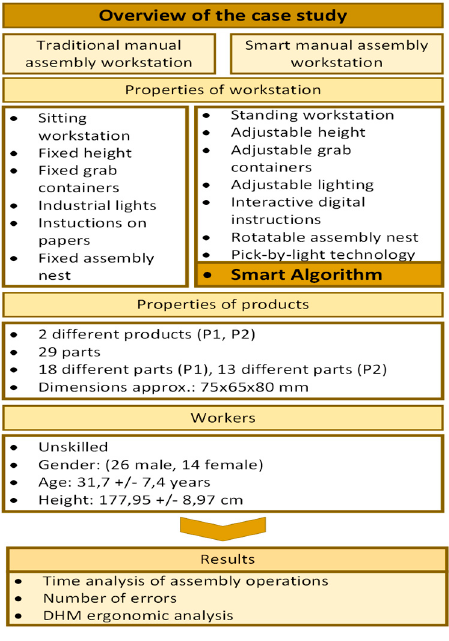
Figure 6. Overview of the case study.